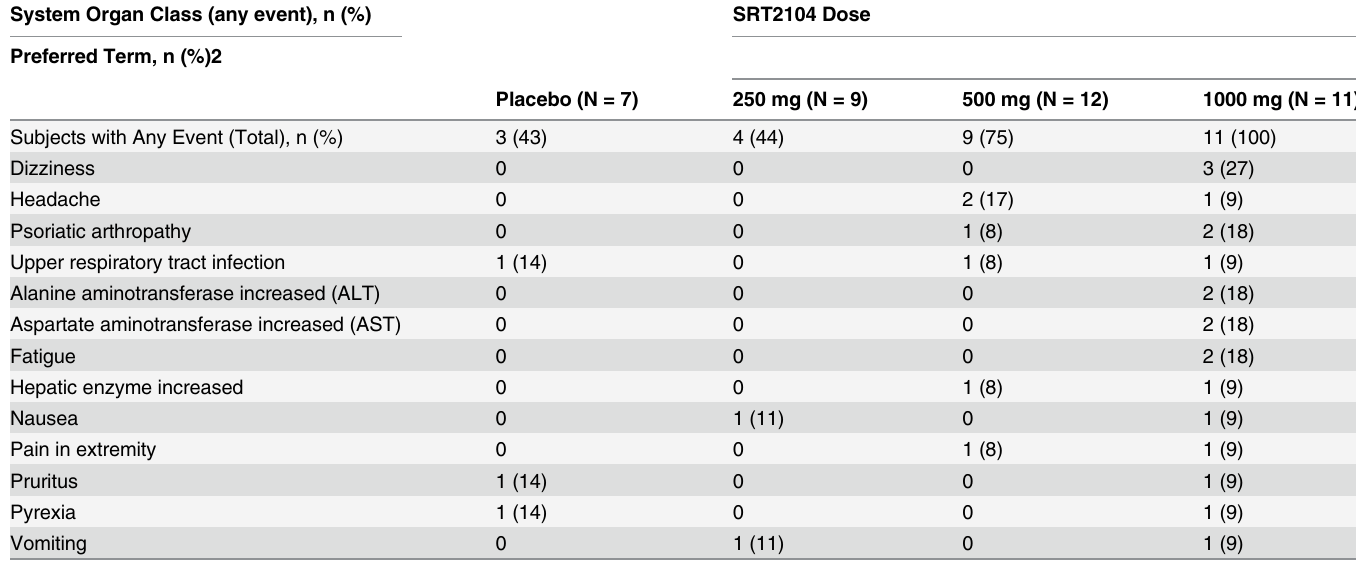
Table 4. Summary of Adverse Events Occurring in > 1 Subject 1